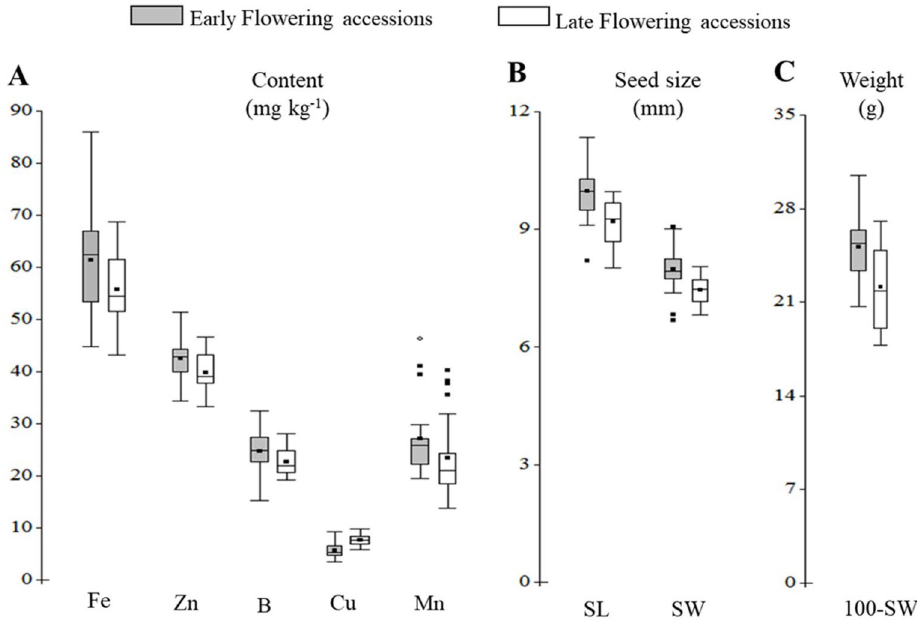
Figure 1. Natural variation in micronutrient content and seed morphological traits among 45 accessions of L. mutabilis . ( A ) micronutrient (Fe, Zn, B, Cu, and Mn) content in mg kg -1 , ( B ) seed length (SL) and seed width (SW), ( C ) 100-Seed Weight